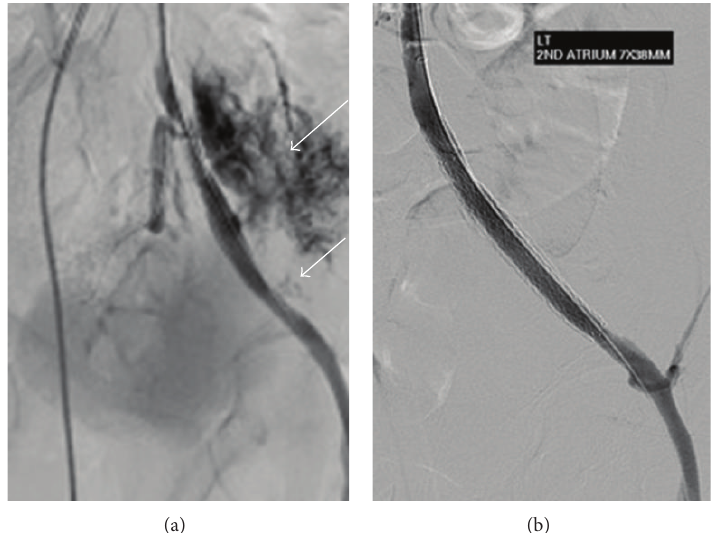
Figure 2: (a) DSA (Digital Subtraction Angiography) image of the left iliac system following insertion of two stents and dilatation. There is vessel rupture with a large amount of contrast extravasation from the proximal portion (upper arrow) of the stented segment and a smaller amount of contrast extravasation from the lower portion (lower arrow). (b) DSA image following insertion of covered stents demonstrating widely patent stented external iliac artery with no further haemorrhage.